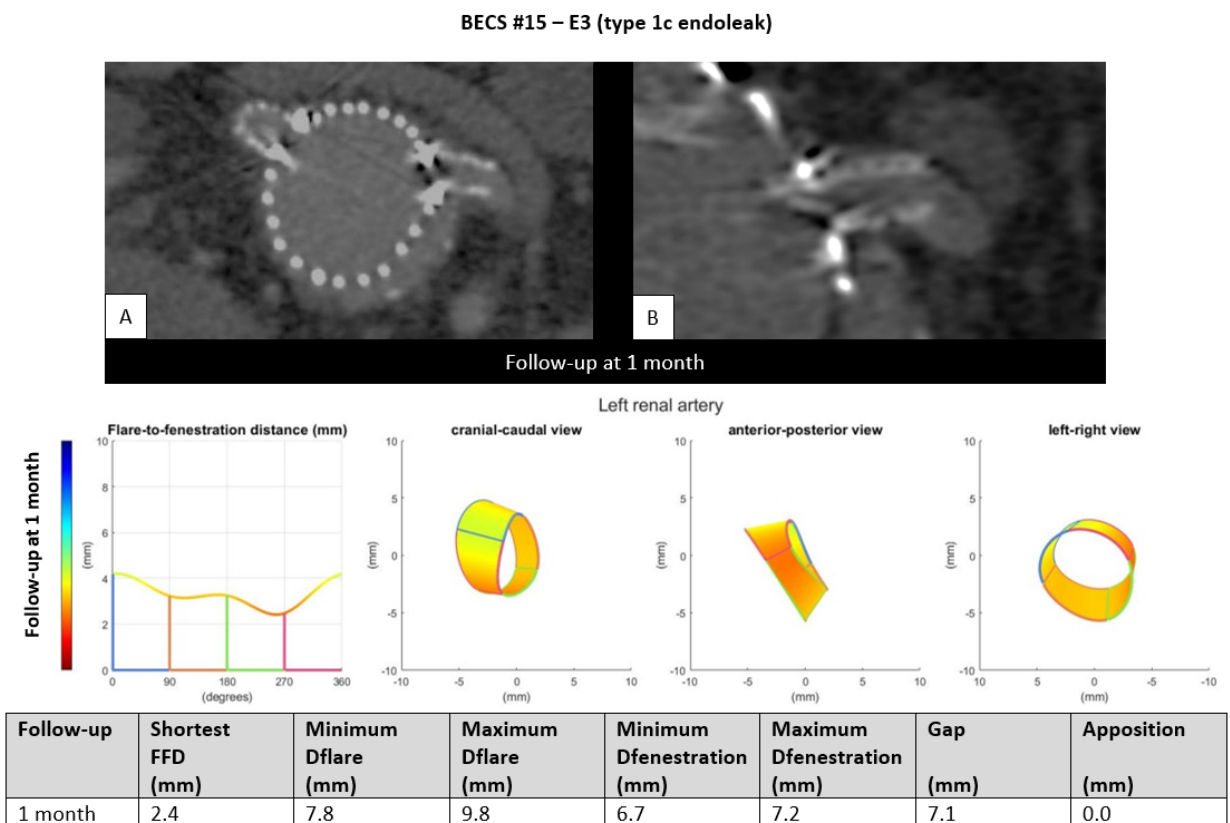
Figure 5. BECS #15 is an example of E3, endoleak due to insufficient circumferential apposition between the BECS and the target artery. The 1 ‐ month post ‐ FEVAR CTA scan (( A ); axial view of the aorta, ( B ); snake view of the left renal artery) reported a type 1c endoleak. Geometric analysis was performed of the 1 ‐ month post ‐ FEVAR CTA scan and reported lack of apposition.